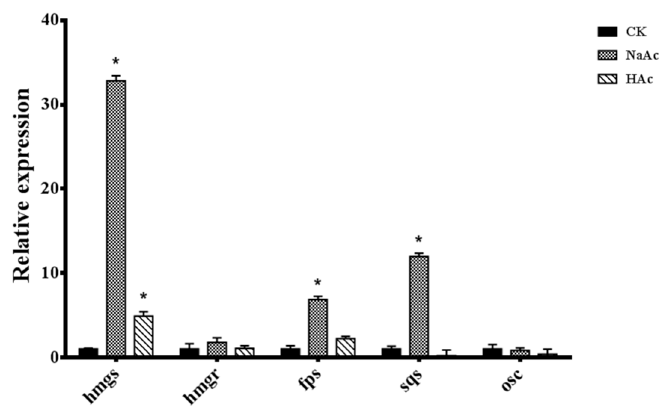
Figure 4. Transcriptional levels of the genes in the triterpenoid biosynthetic pathway. The expression level of the samples from the CK strain is defined as 1.0, and expression levels in the treatment strain are displayed in relation to the reference sample. The error bars indicate the standard deviations from three independent samples. * indicates a statistical significance ( p < 0.05) compared to the CK strain. CK, control check; hmgs , hydroxymethylglutaryl-CoA synthase; hmgr , 3-hydroxy-3-methylglutaryl coenzyme A; fps , farnesyl pyrophosphate synthase; osc , oxidosqualene cyclase; sqs , squalene synthase; HAc, acetic acid; NaAc, sodium acetate.